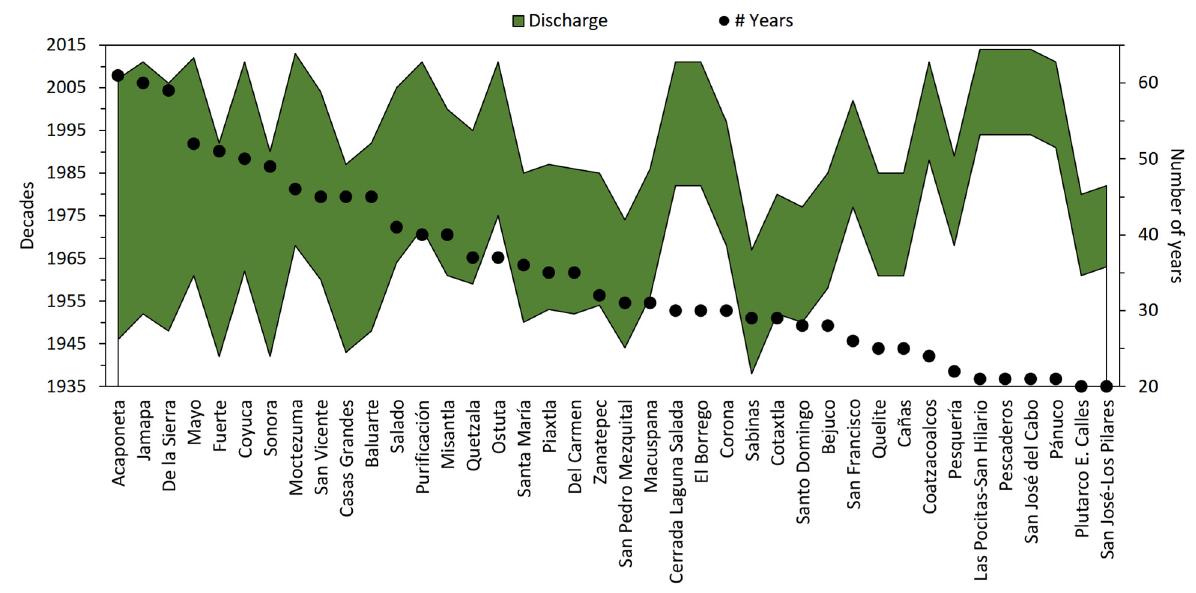
Figure 2. Periods of streamflow analysis of the river sites. Decades comprised in the left vertical axis (colored area), while the number of consecutive years in the right vertical axis (dots).